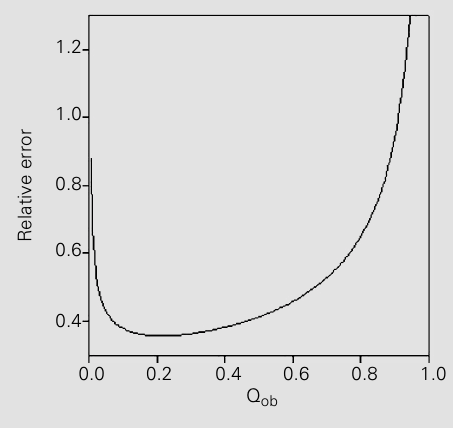
Figure 2 - Graphic representa- tion of a map from η to N. In this example, 4 subsets with Q ob i outcomes obtained at the η = 50 level result in a single putative Q pu at the N = 200 level. Such a Q pu is best represented by the mean of the observed Q ob i at the η level (see text and Appen- dix A, page 947). Notice the re- duction in the relative error from each of the independent Q ob i that occurs when the set is evaluated as a single putative fraction of events.